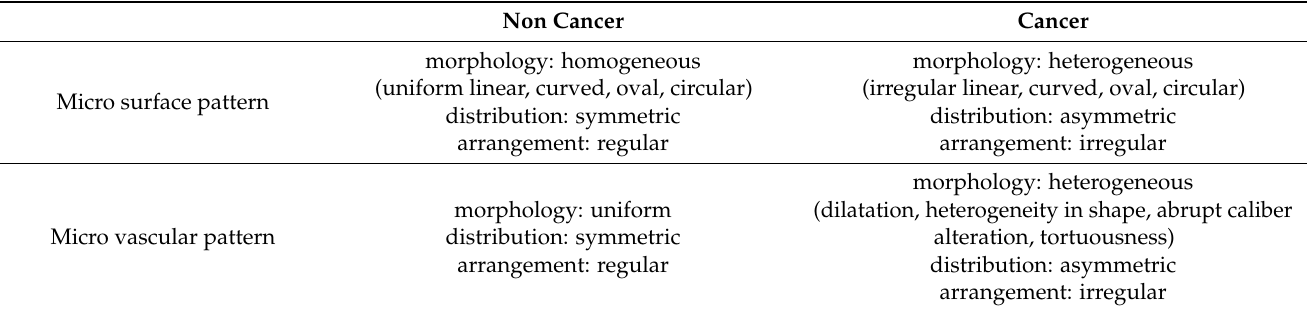
Table 1. Differences in MSP and MVP between cancer and non-cancer.